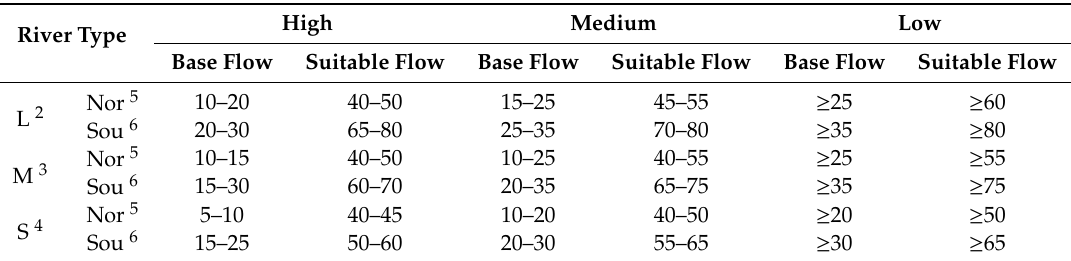
Table 6. Recommended environmental flows thresholds 1 for di ff erent rivers in